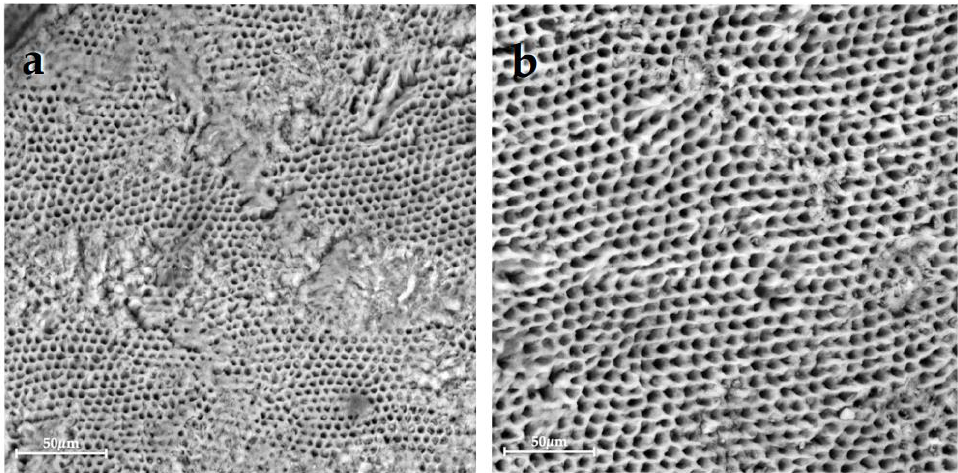
Figure 2. Scanning electron micrographs of Group 2 highlighted ( a ) at 500× magnification, showing the enamel surface with many exposed enamel prisms, the destruction of interprismatic spaces, and the loss of the interprismatic substance; and ( b ) at 1000× magnification, showing a honeycomb structure and a typical demineralized morphology of the enamel with the loss of the core of prisms.